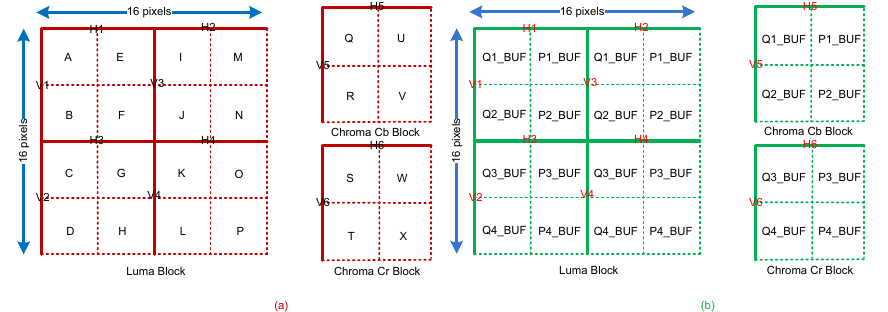
Figure 8. Mapping of pixel blocks to buffers: ( a ) pixel blocks; ( b ) buffers.